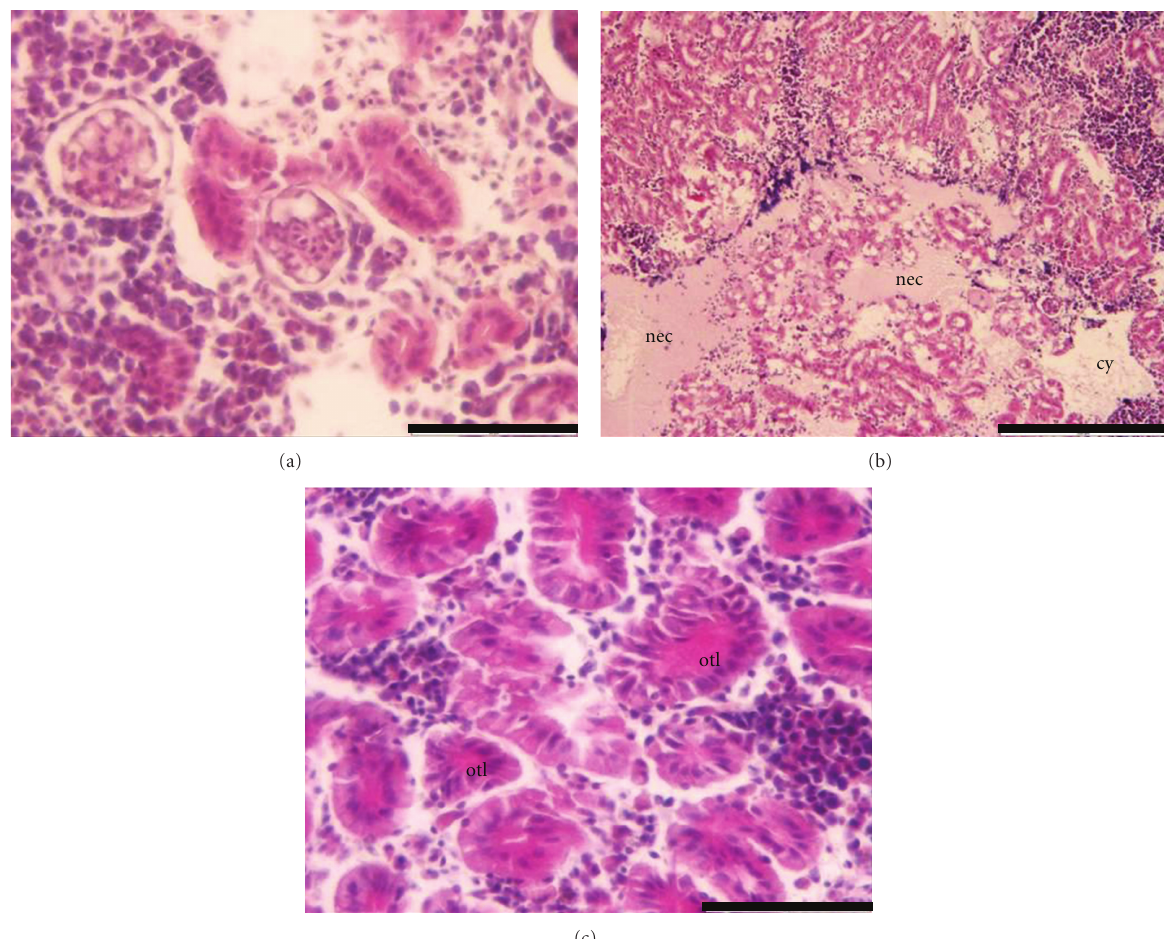
Figure 2: Histopathological observations in the kidney of Diplodus cervinus after 28 days of exposure to Hg 2+ . (a) control group: posterior kidney section (bar = 50 µ m); (b) exposure to Hg 2+ : posterior kidney section showing a massive necrosis area (nec) and cytolysis (cy) (bar = 200 µ m). (c) exposure to Hg 2+ : occlusion of the tubular lumen (otl) (bar = 50 µ